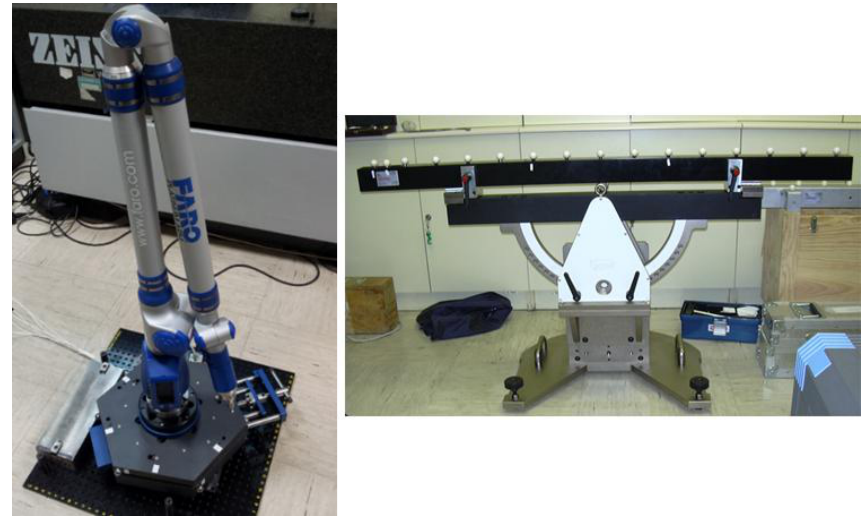
Figure 24. Faro Platinum measuring arm mounted on IMP and ball bar calibrated gauge used in the